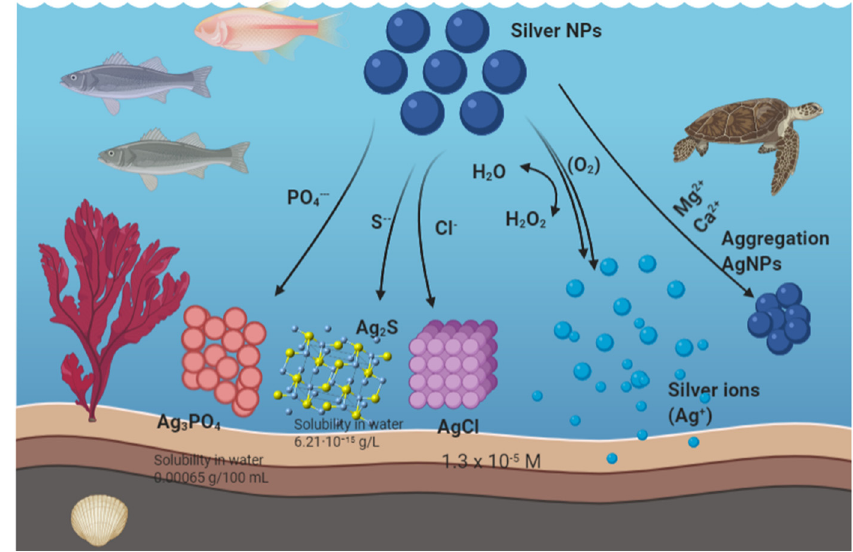
Figure 3: Behavior of AgNPs in freshwater ecosystem.